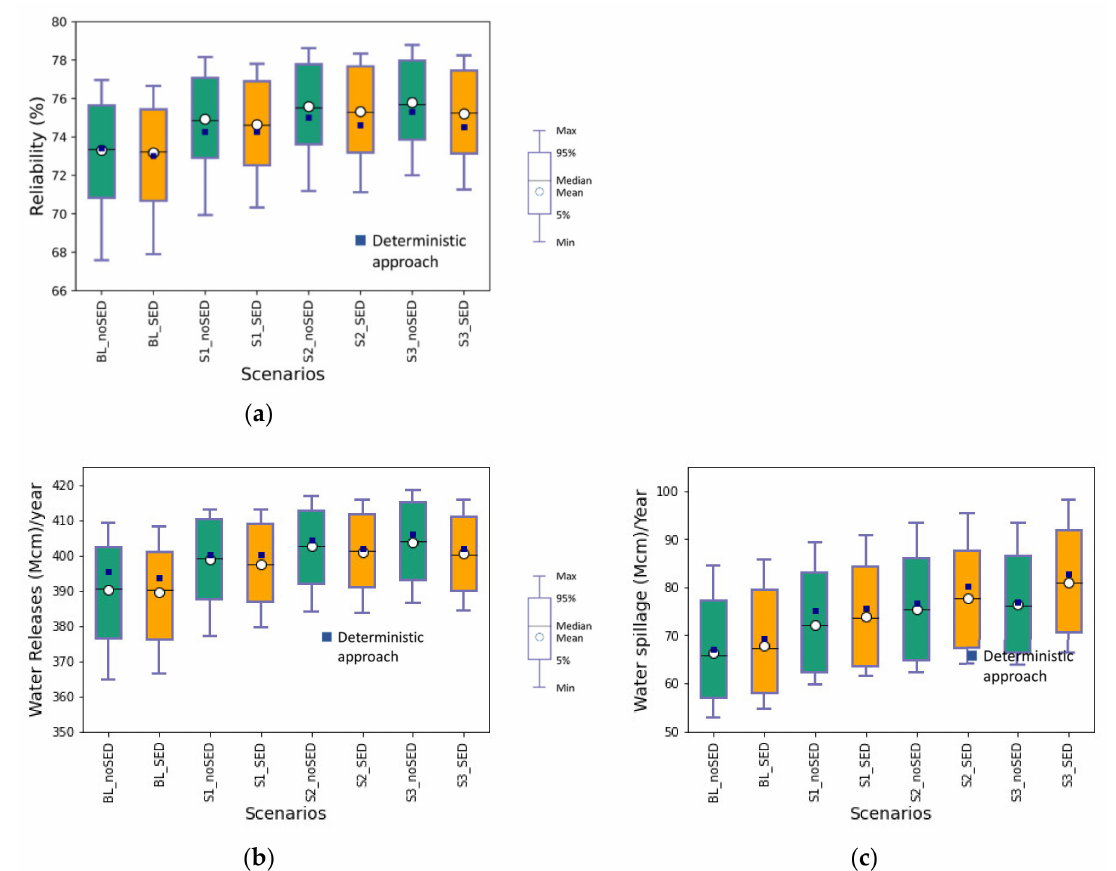
Figure 10. Impact of land-use changes on the reliability ( a ), water release ( b ), and water spillage ( c ) using the proba- bilistic and deterministic approaches for the 10-year period. (the suffix:_NoSED: Sedimentation not considered; _SED: Sedimentation